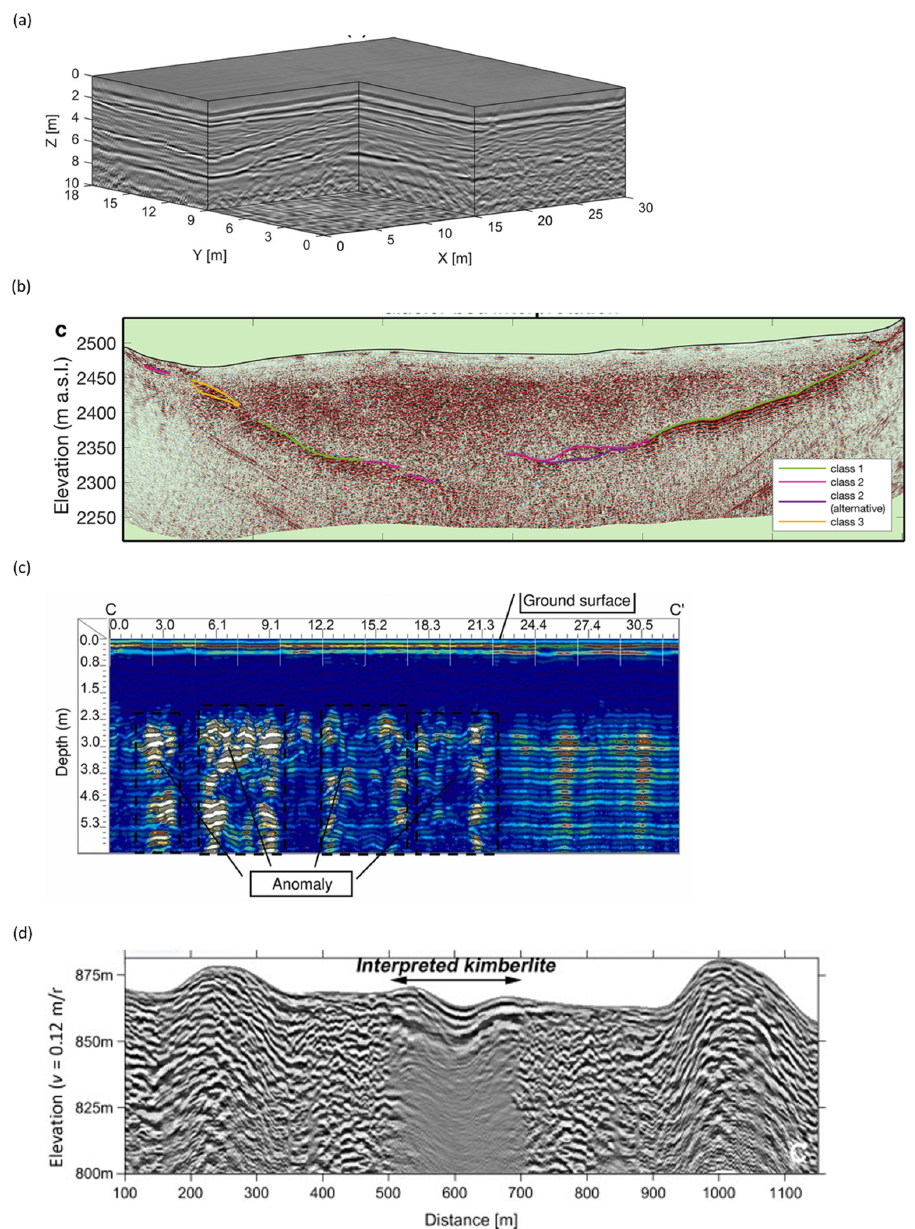
Figure 4. Examples of GPR applications for environmental studies. ( a ) A 100 MHz GPR volume delineating the geometry of an alluvial aquifer and exhibiting the dominant dip of the sediments. ( b ) Glacier bed interpretation and reflection quality classification from a 25 MHz GPR profile over a Swiss valley glacier. ( c ) GPR profiles and location of detected anomalies and sinkhole data from a 270 MHz equipment. ( d ) A 30 MHz radar profile showing the occurrence of a non-diamondiferous kimberlite pipe. Adapted with permission from [178,188,204,223]. Copyright 2012/2022, Elsevier.